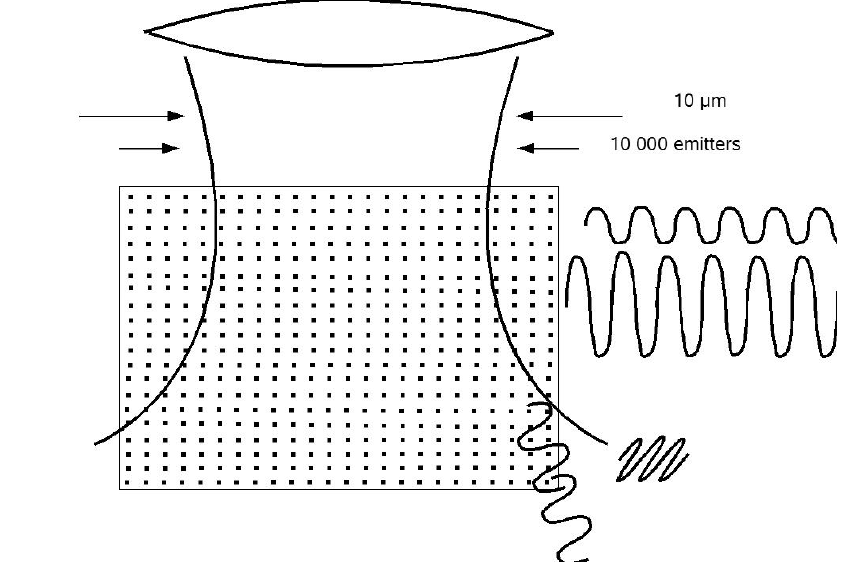
Figure 1. The geometry in a real multi-atom or molecules light source. Always billions of emitters are involved and cooperating bunches are emitted. Even a poor-quality source reveals some coherence (see also next